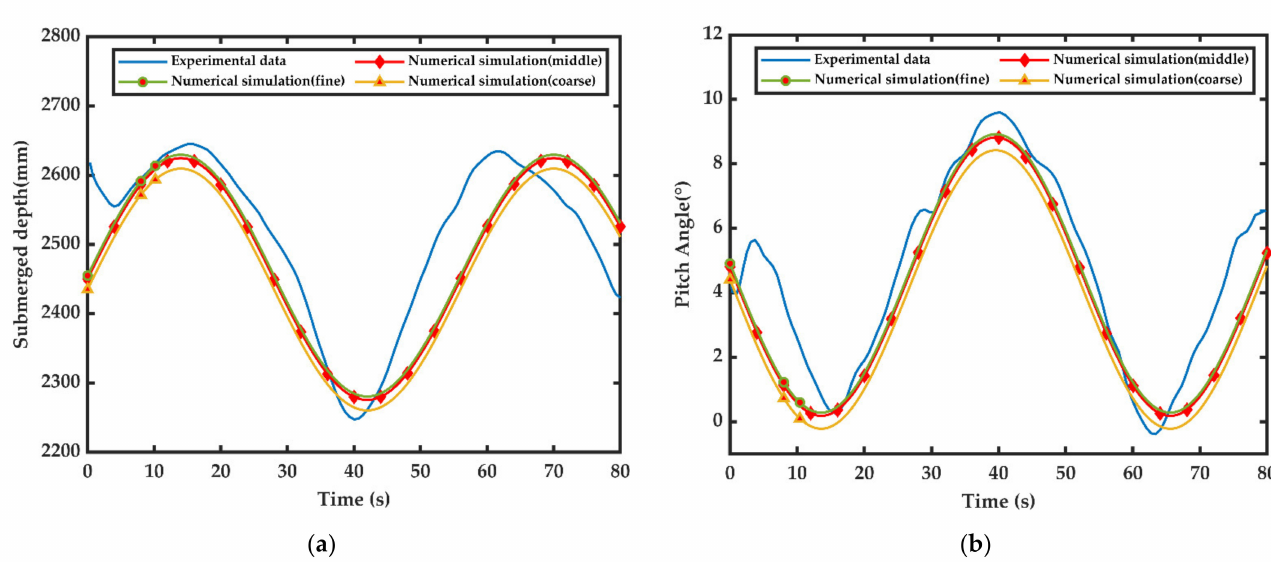
Figure 6. The comparison of submerged depth and pitch angle between experiment and numerical simulation. ( a ) The tethered underwater robot’s submerged depth. ( b ) The tethered underwater robot’s pitch